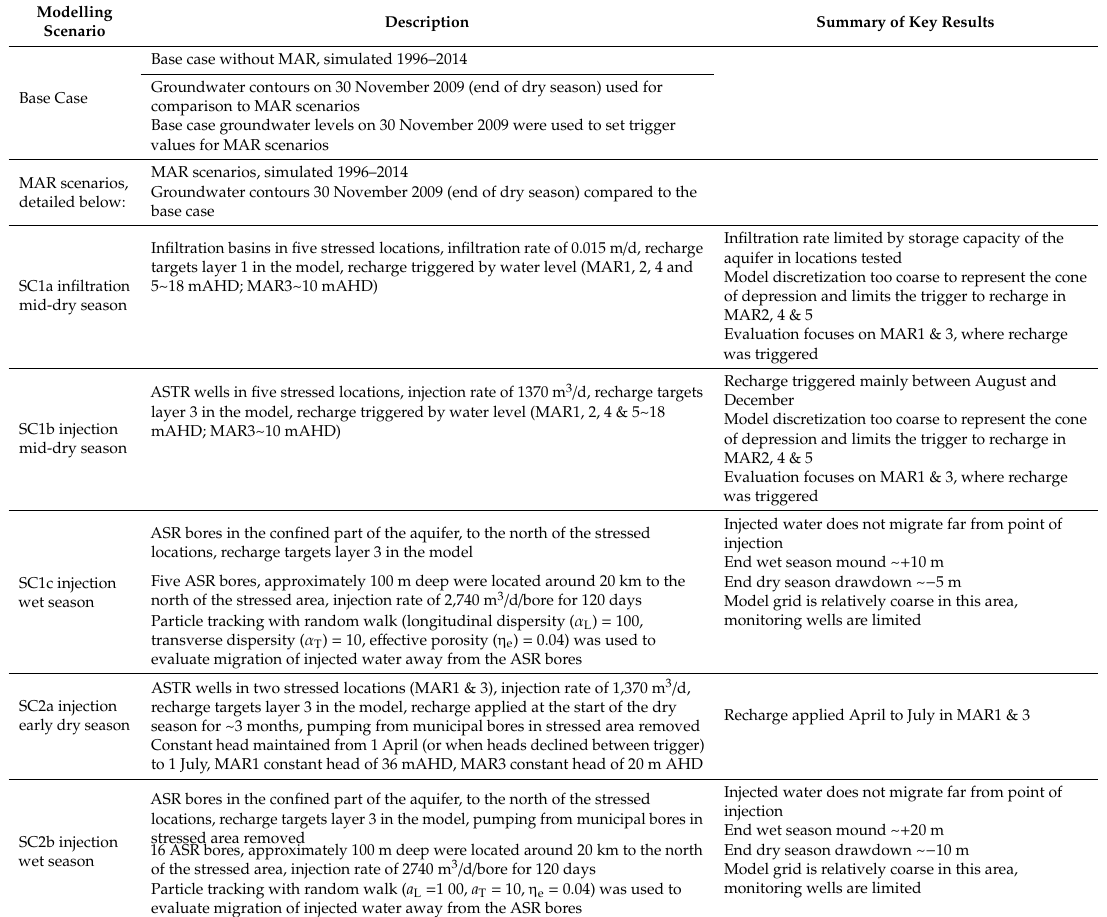
Table 1. Howard East modelling